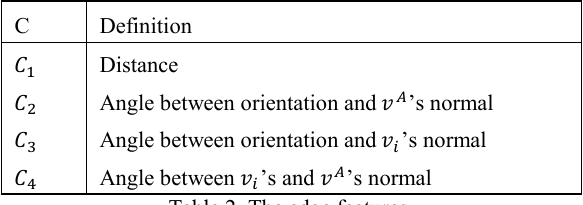
Table 2. The distance is the Euclidean distance between two center points in   . The edge orientation is the vector between two center points of nodes in   .